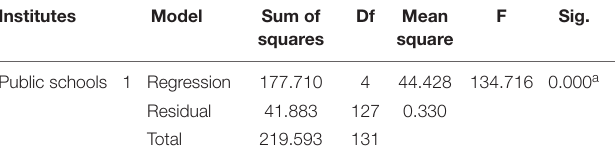
TABLE 7 | The ANOVA results for public school students.